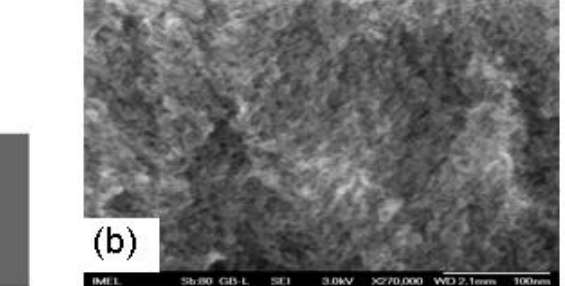
Figure 2. ( a ) Cross sectional schematic representation of the porous Si layer on the Si substrate. ( b ) Cross sectional scanning electron micrograph of the porous Si layer depicting its sponge-like